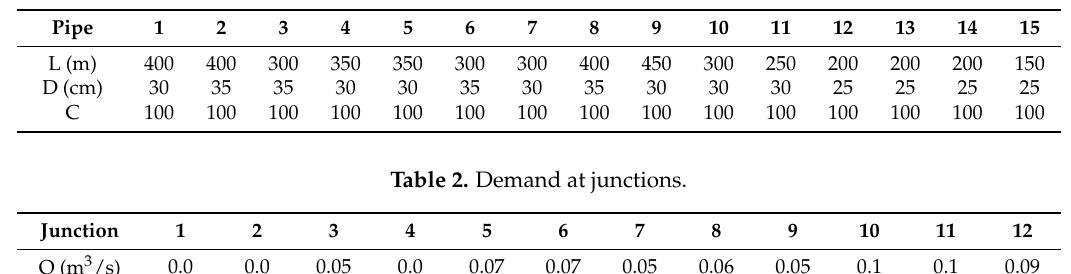
Table 1. Pipe properties of sample pipe network.